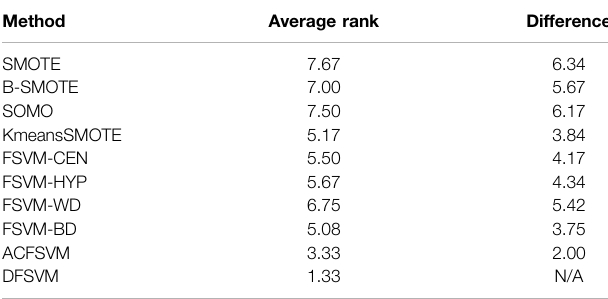
TABLE 3 | Average ranking of different methods on G-mean and its ranking difference with